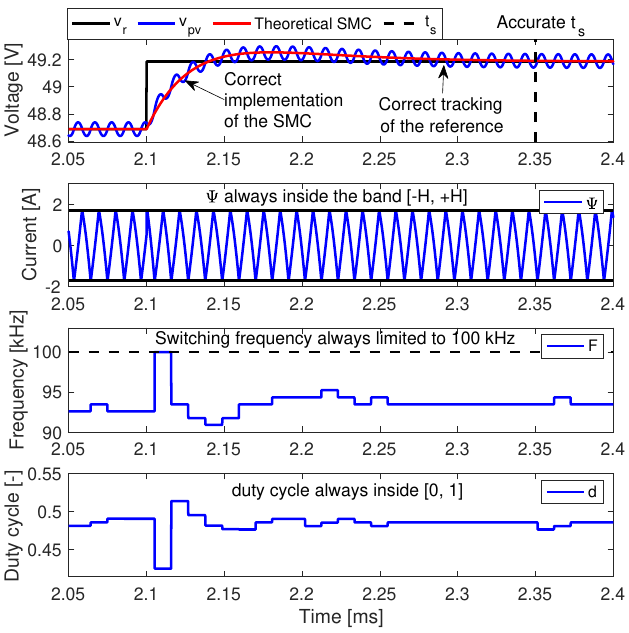
Figure 15. Performance of the PV system to changes on the reference value.